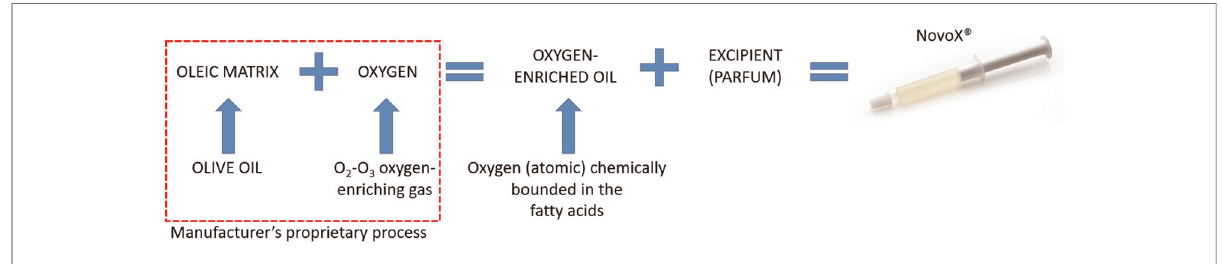
FIGURE 4 Novox medical device components and manufacturing